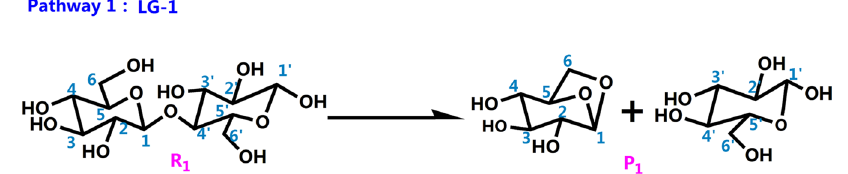
Figure 5. Pathway 1 reaction process.